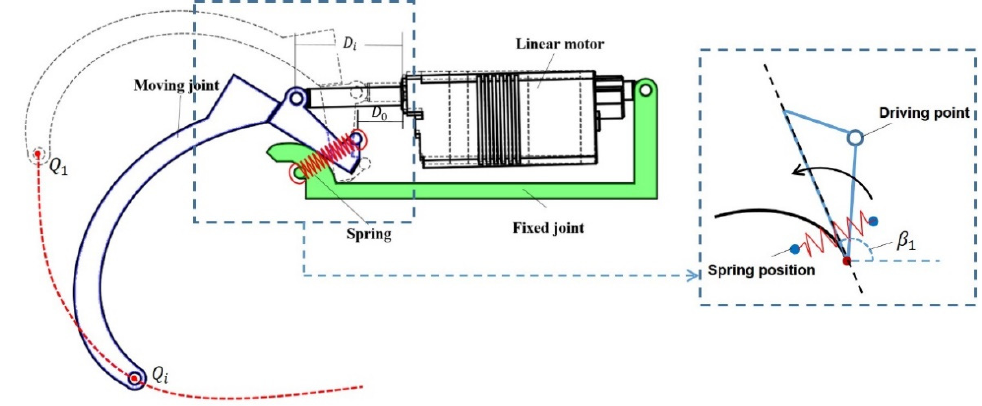
Figure 6. Diagram of the involute finger exoskeleton.